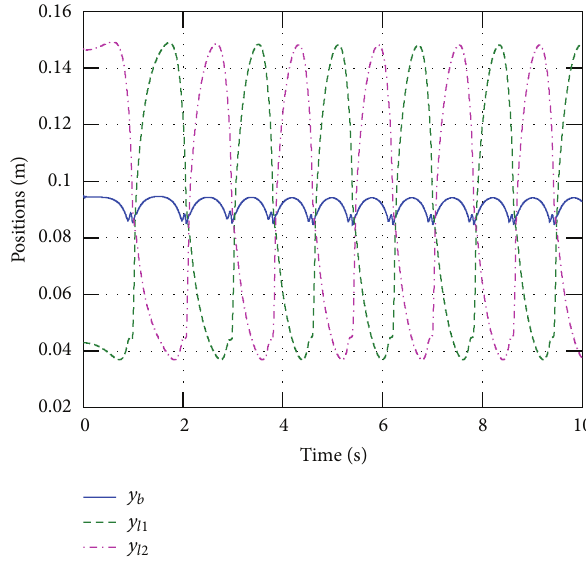
Figure 8: 𝑌 direction positions of the body and the legs ( 𝑦 𝑏 : body, 𝑗 ). The 𝑌 direction positions of the body and the legs repeat- 𝑦 𝑙𝑗 : leg edly increase and decrease. The positional relationship between the legs shows that the quadruped robot rolls with switching the supporting leg.